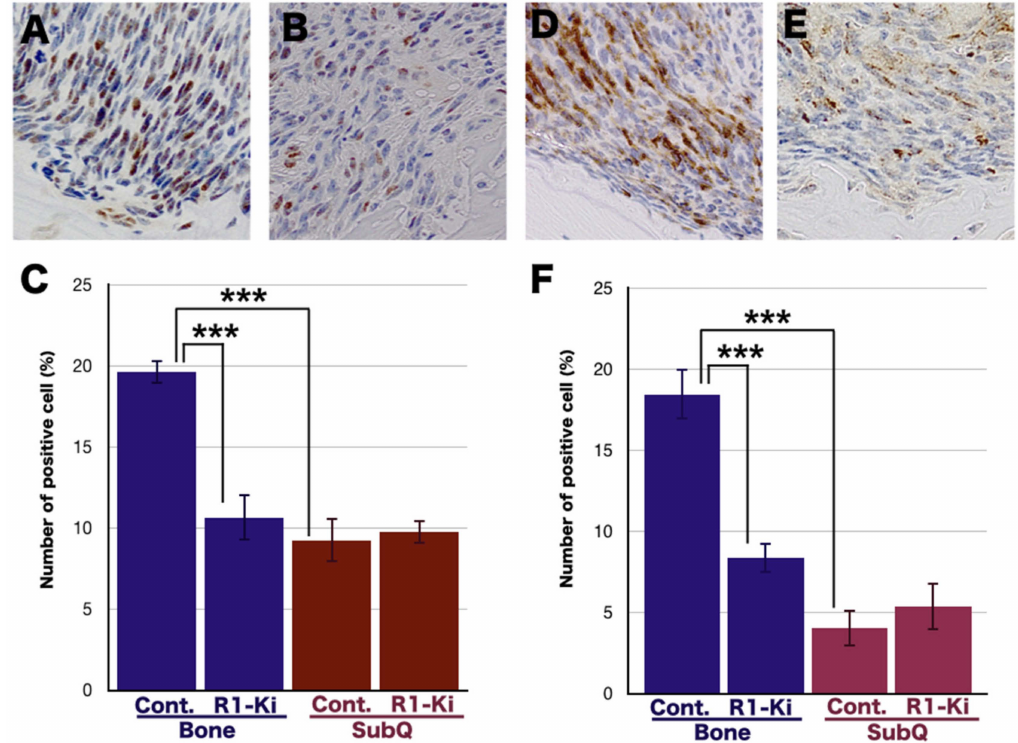
Figure 5. The e ff ect of TGF- β signaling on the induction of CSC in the bone micro-E. ( A , B ) IHC study of SOX2 staining in the bone micro-E: A large number of SOX2 positive cells can be seen in the control group ( A ) and fewer positive cells in the R1-Ki treatment group ( B ). Magnification: 600 × . ( C ) Quantitative analysis: R1-Ki treatment resulted in a significant suppression of SOX2 positive cells in the bone micro-E but not in the subQ micro-E. ( D , E ) IHC study of CD166 staining in the bone micro-E.; A large number of positive cells can be seen in the control group ( D ) and fewer positive cells in the R1-Ki treatment group ( E ). Magnification: 600 × . ( F ) Quantitative analysis; R1-Ki treatment resulted in a significant suppression of CD166 positive cells in the bone micro-E, but not in the subQ micro-E. ***: p <